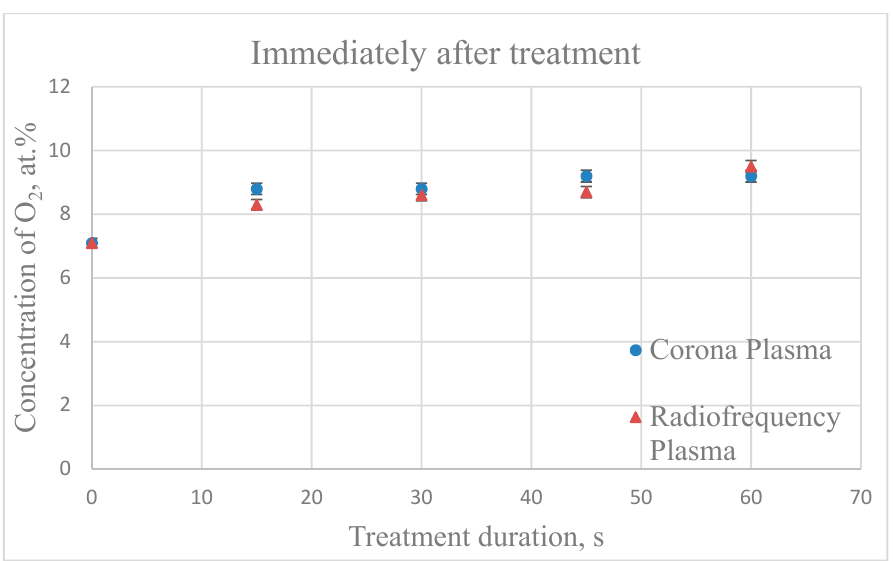
Figure 8. The surface concentration of oxygen (atomic percent) in the surface layer of catheters vs. the duration of plasma treatment as established immediately after the treatment with SEM/EDS spectroscopy is depicted.